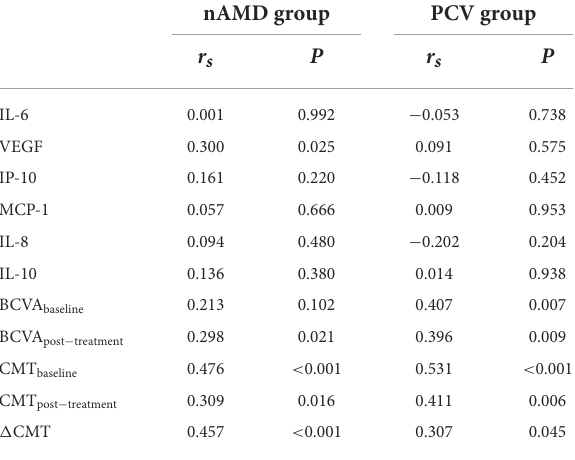
TABLE 3 Correlation between HF and AH concentrations (pg/mL) of cytokines and clinical characteristics in nAMD and PCV groups.